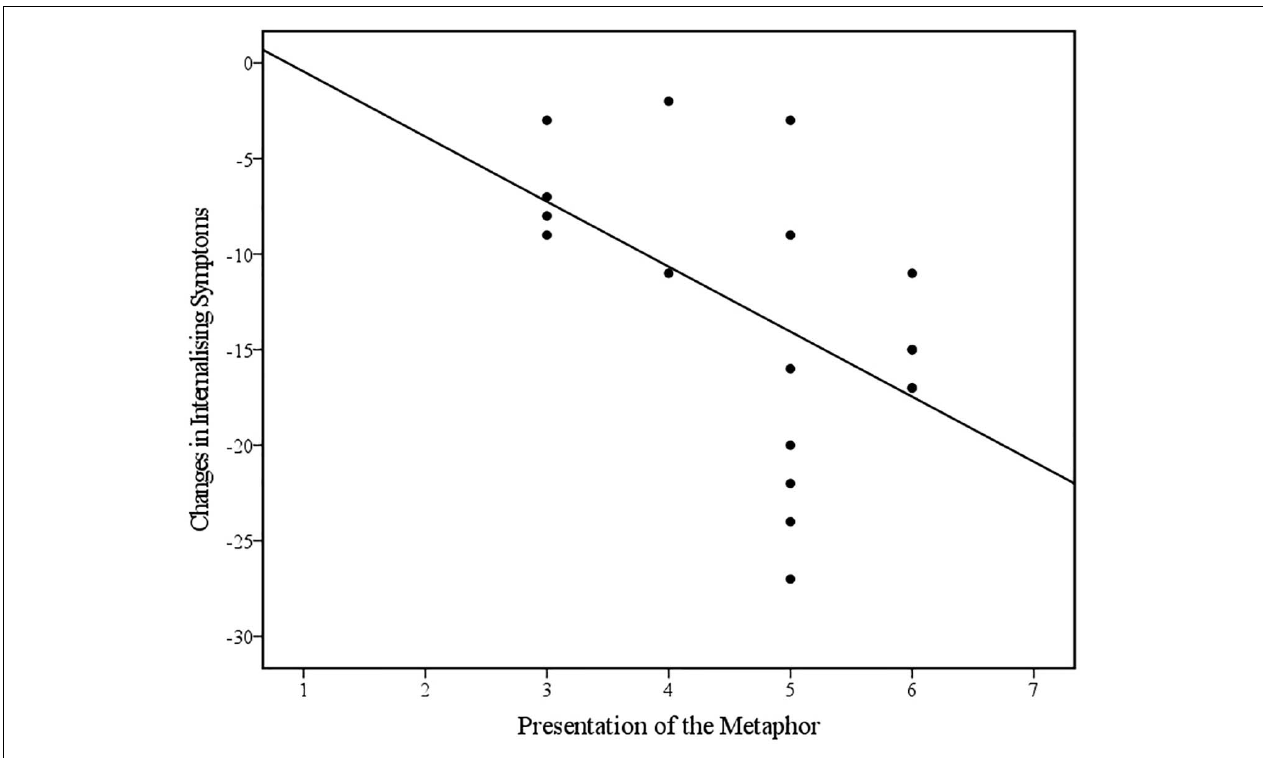
FIGURE 5 | Scatterplot and line of best fit (linear) illustrating the relationship between the therapist’s Presentation of the Metaphor and changes in Internalising Symptoms on the CBCL across treatment ( N = 18) (Linear equation: y = 2.96–3.4 × ; R 2 = 0.27).